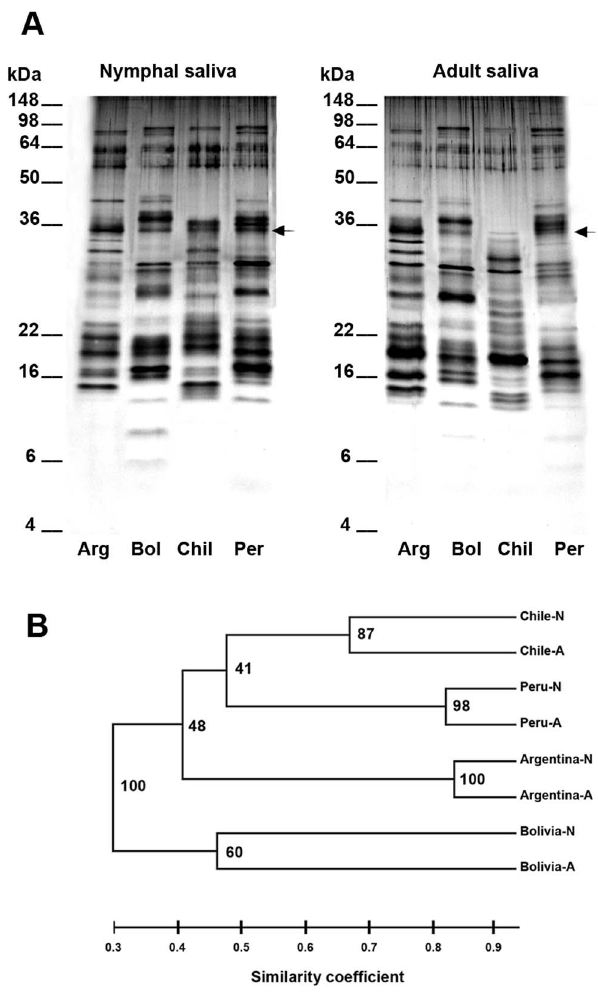
Figure 2. Nymphal and adult salivary profiles of four different T.infestans strains. (A) Saliva of starved nymphs (fifth instar) and adults (pooled saliva of females and males) of four different T. infestans strains from Argentina (Arg), Bolivia (Bol), Chile (Chil) and Peru (Per) were analyzed by SDS PAGE. Arrows mark the protein band of 35 kDa that is common for all T. infestans strains. (B) An unrooted phenogram was constructed from the electrophoretic salivary profiles of nymphs (N) and adults (A) of the different T. infestans strains using the UPGMA method of the FreeTree software [50]. Bootstrap values are displayed at the tree nodes and the scale bar represents the Dice’s similarity coefficient.